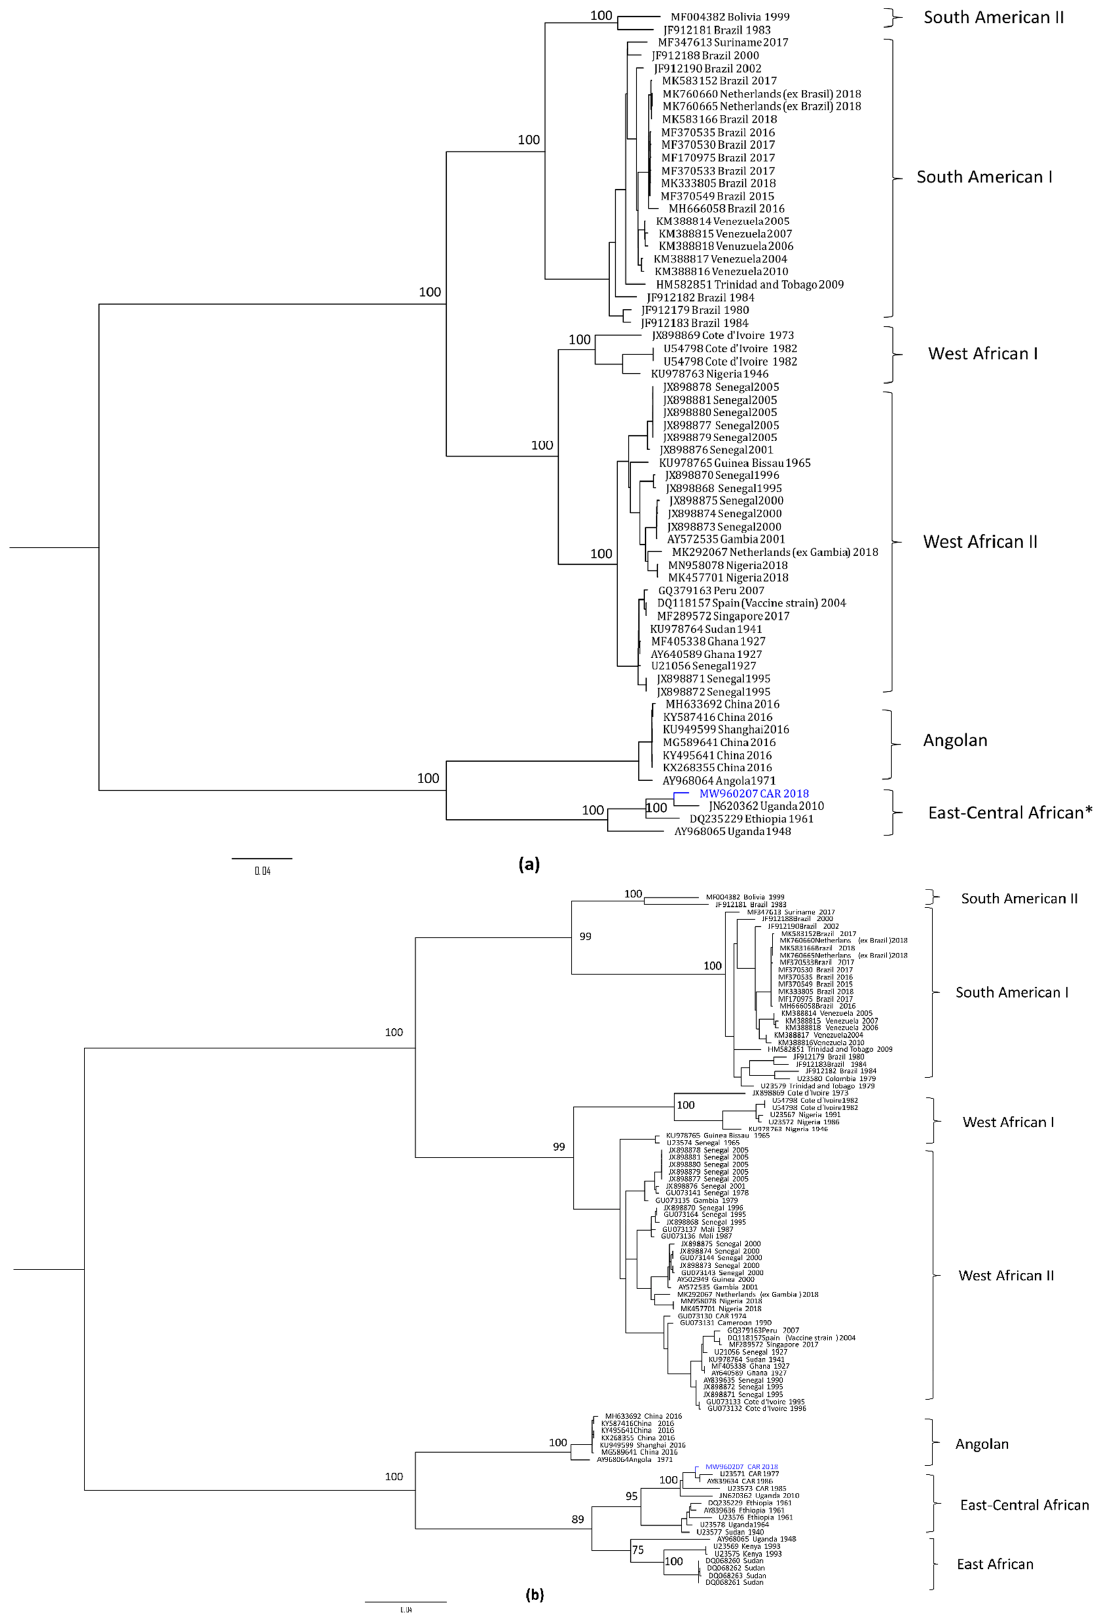
Figure 3. Maximum-likelihood phylogenetic tree of the yellow-fever virus. The figure shows the maximum-likelihood trees built using IqTree v1.6.12 software based on the whole yellow-fever vi- rus (YFV) genome (panel ( a ), GTR + F + R2 substitution model, 10,548 bp) or the envelope gene only (panel ( b ), TIM2e + I+G4 substitution model, 1455 bp). The strain described in this study is shown in blue. In panel ( a ), East African and East–Central African genotypes, indicated by an asterisk (*), cluster together artificially likely due to the lack of available full-length sequences. This observation agrees with the results of the molecular-clock analysis (Figure 4), which shows that the most recent common ancestor (TMRCA) of YF-118 and two other CAR YFV strains appeared around year 1955 (95% highest posterior density (HPD) 1937– 1966), some 63 years ago, whereas this clade diverged from the clade of Uganda 2010 around year 1918 (95%HPD 1882–1952), implying a recent evolution of YFV in the CAR. These estimates are compatible with the predicted emergence of the East–Central African genotype, some 250 years ago [25,27], and the slower evolutionary rate of YF viruses, es- pecially compared with other flaviviruses, including dengue viruses [28].